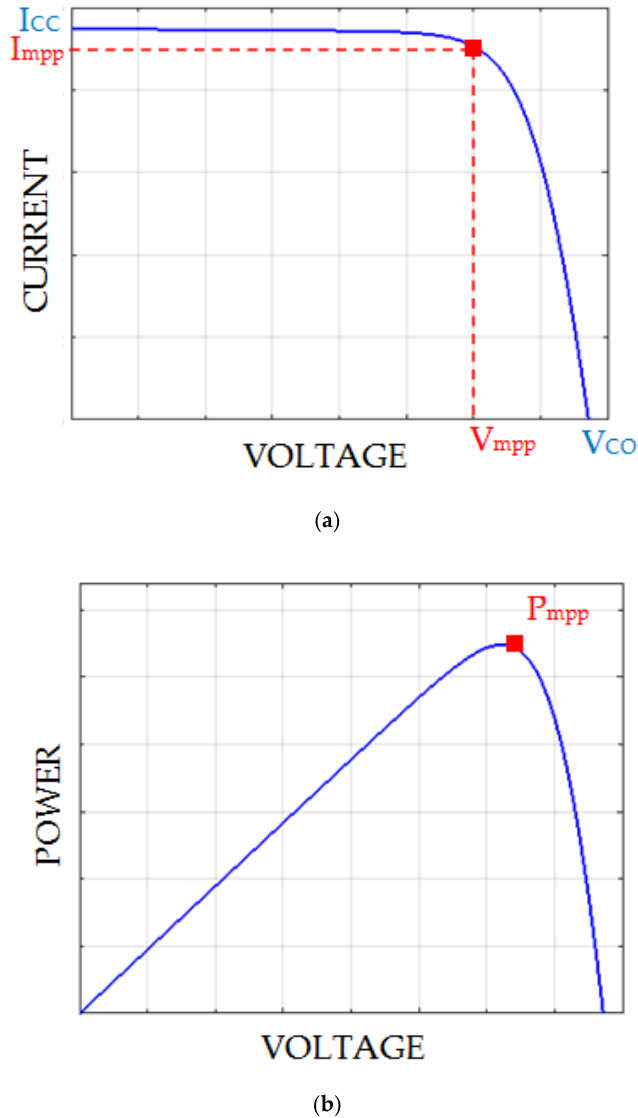
Figure 3. ( a ) Current–voltage characteristic; ( b ) power–voltage characteristic.